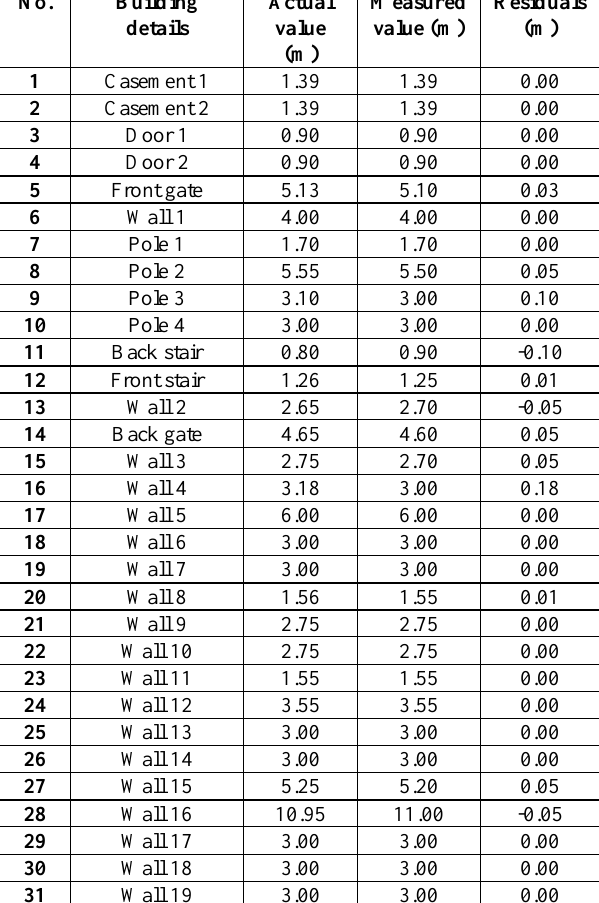
Table 2 indicates the 60% of the residuals gave zero value. It is means that the 3D model has the same value with the actual measurement. While the other sample has the residual at the centimetre and millimetre